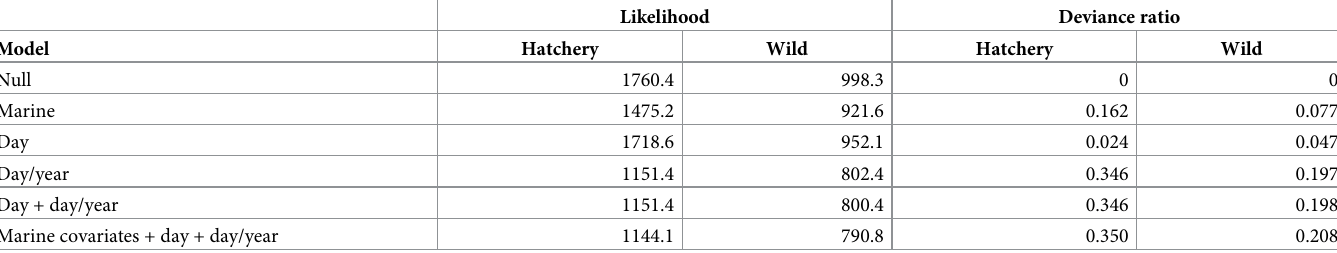
Table 6. Deviance ratios for top